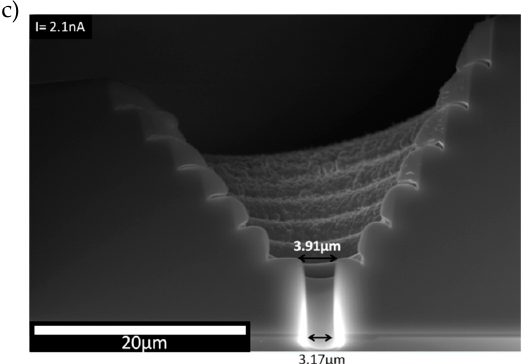
Figure 3. Top and bottom view (inset) SEM images of the micropore fabricated at a milling current of ( a ) 9.3 nA and ( b ) 2.1 nA. ( c ) cross-sectional view of the conical-shaped micropore structure milled at 2.1 nA.